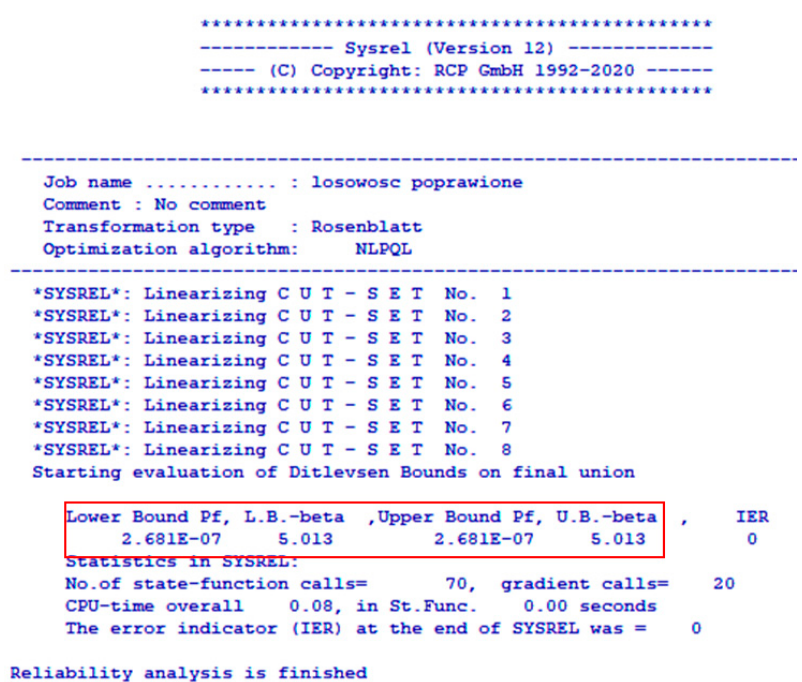
Figure 9. Results of the reliability analysis in the SYSREL program for the advanced model.